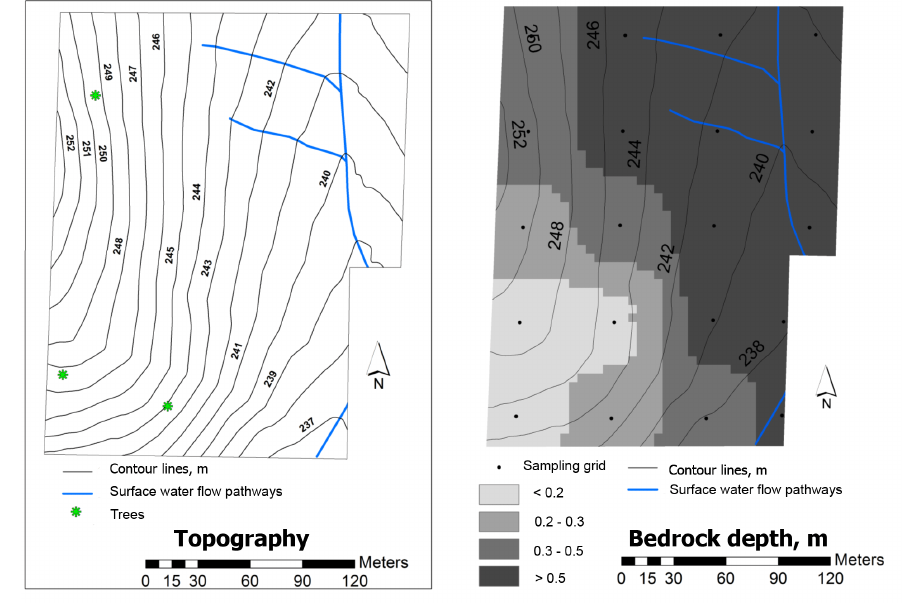
Figure 3. Topography map ( left ) and bedrock depth ( right ) of the experimental field